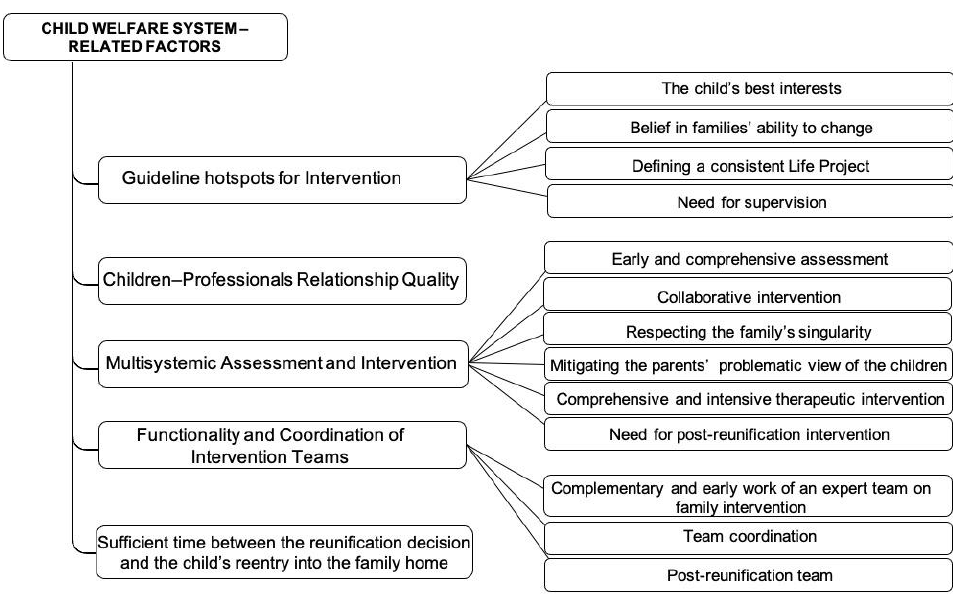
Figure 1. Child-Welfare-System-Related Factors — Thematic categories and respective subcategories with an influence on the family reunification process.